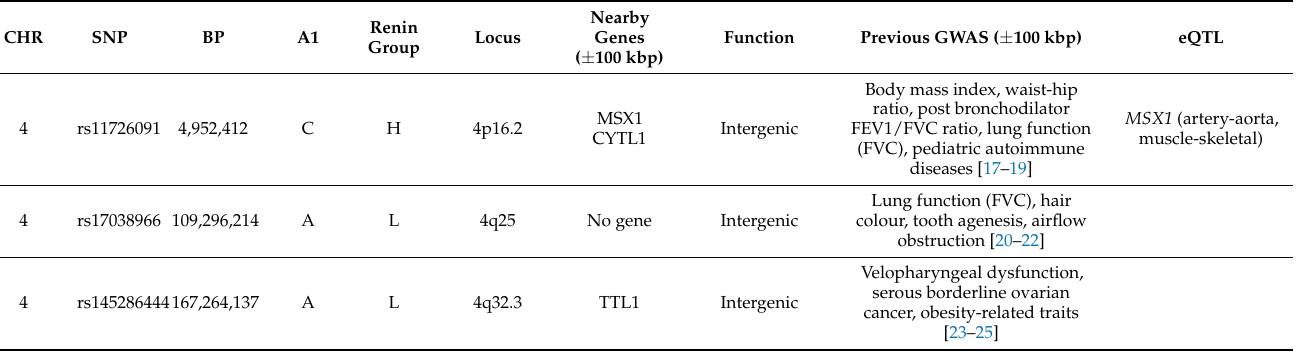
Table 3. Interpretations of significant